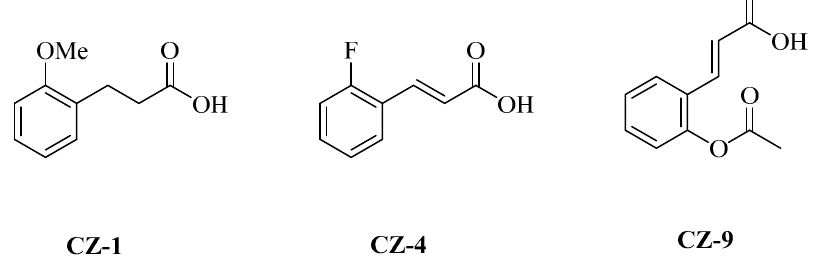
Figure 1. Chemical structures of three bioactive compounds. Table 1. Screening for inhibitors of Xoo T3SS by fluorescence-activated cell sorting assays.